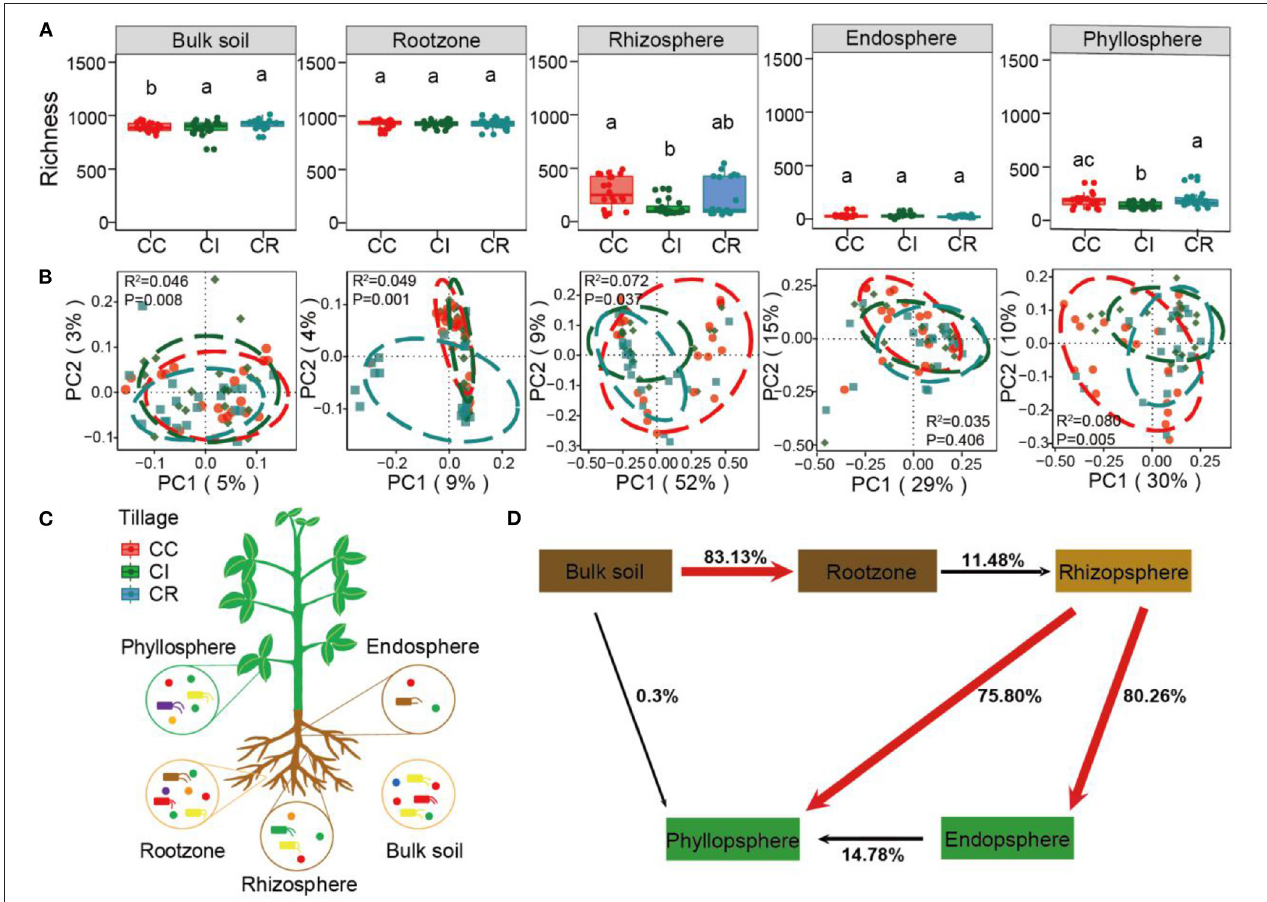
FIGURE 1 | The α diversity and β diversity of bacterial communities in soil-plant continuum compartments under continuous cropping (CC), intercropping (CI), and crop rotation (CR) systems. (A) Represents the richness index calculated by the bacterial ASVs table. According to PCoA determination (B) , the bacterial community structure of three cropping systems (CC, CI, and CR) in five soil-plant continuum compartments (bulk soil, root zone, rhizosphere, endosphere, and phyllosphere). A 85% confidence ellipse with the same color as the patch was shown around the sample. (C) Is based on soil-plant continuous compartment niche sampling layout and (D) is a plant microbiome source model (SMPM) showing potential sources of soil-plant continuum-associated bacterial communities for each niche. The same lowercase letters indicate no statistically significant ( P < 0.05) difference between cropping